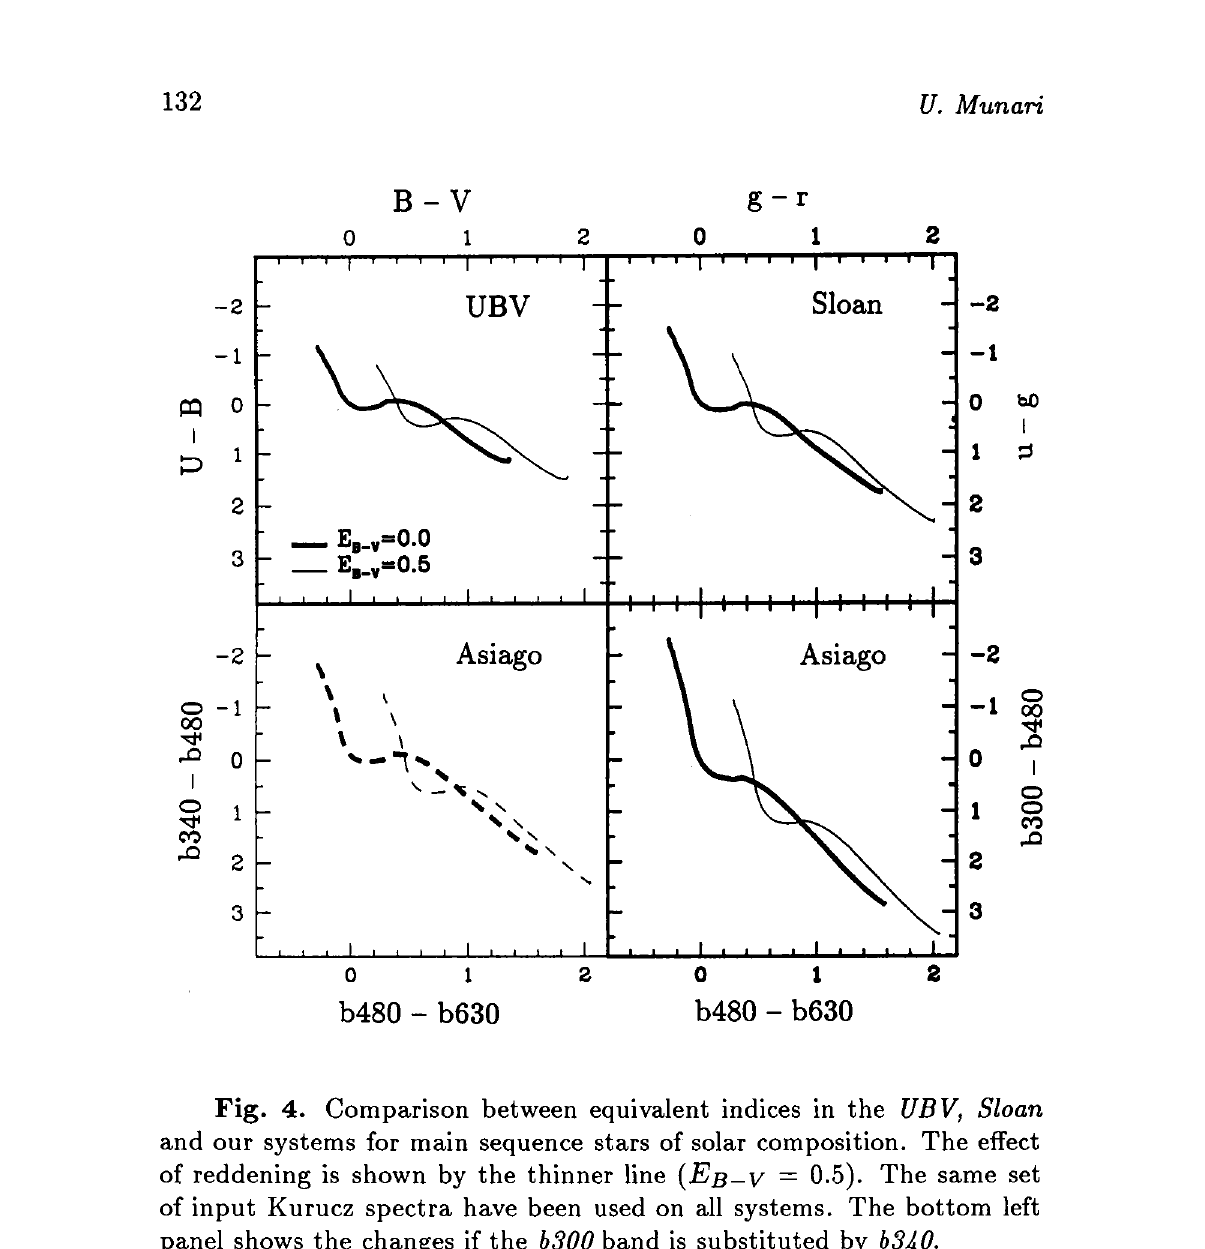
Fig. 4. Comparison between equivalent indices in the UBV, Sloan and our systems for main sequence stars of solar composition. The effect of reddening is shown by the thinner line ( E g -V = 0.5). The same set of input Kurucz spectra have been used on all systems. The bottom left panel shows the changes if the b300 band is substituted by